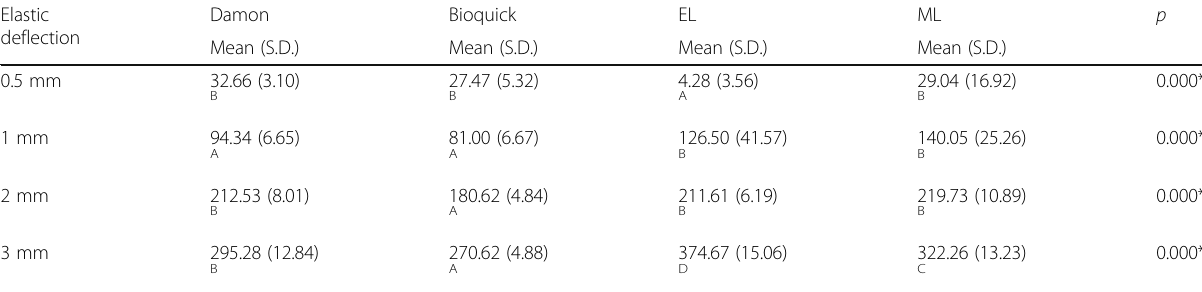
Table 6 Mean (in cN) and standard deviation (SD) of 0.016-in. thermally activated NiTi wires, in the bracket systems ( n = 10) Elastic deflection